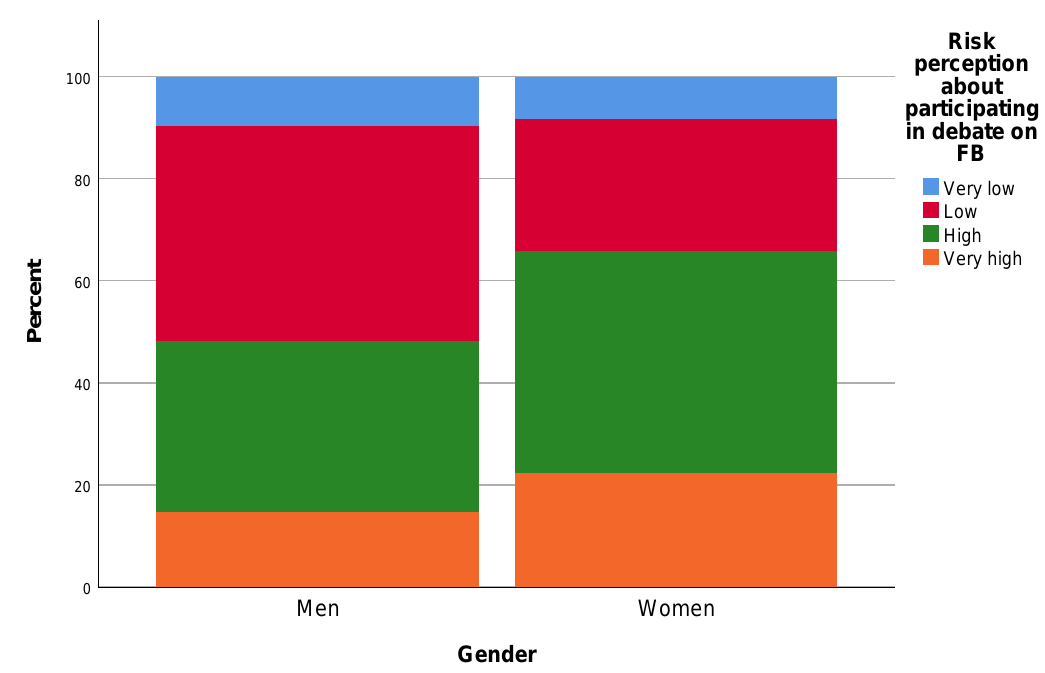
Figure 8. Shows how women and men perceive the risk of participating in debate on